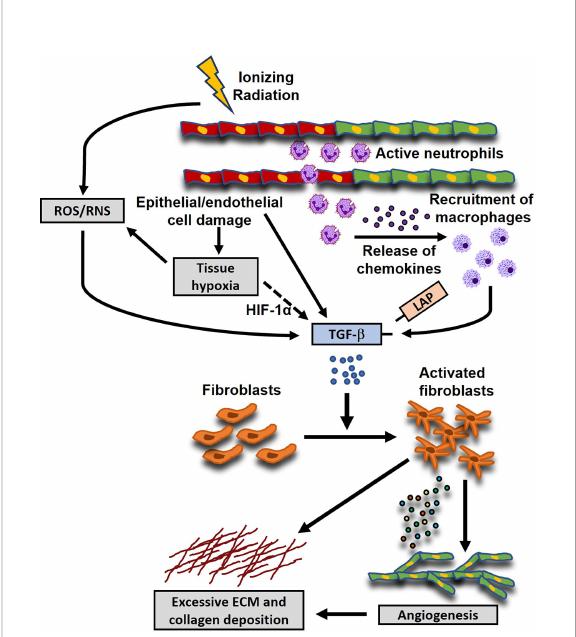
FIGURE 1 Proposed mechanisms of radiation-induced myocardial fi brosis (RIMF). Ionizing radiation damages epithelial and endothelial (shown here; red- and green-colored cells are damaged and healthy cells, respectively) cells which in turn induce a coordinated cellular response that also involves the secretion of pro- fi brotic cytokines, such as Transforming Growth Factor b (TGF- b ). Moreover, the damaged endothelial cells secrete in fl ammatory chemokines to recruit neutrophils and macrophages to the injured sites, which in turn release pro- fi brotic cytokines like Platelet-Derived Growth Factor (PDGF), basic Fibroblast Growth Factor (FGF), TGF- b , etc., leading to a chronic in fl ammatory environment. Additionally, radiation causes perturbations of the cellular homeostasis by the excessive production of reactive oxygen and nitrogen species (ROS and RNS), which can also lead to the activation of TGF- b through the dissociation of the Latency Associated Peptide (LAP) from the active mature form of TGF- b . Another potential mechanism is that the damaged vasculature and the uncontrolled tissue remodeling can initiate the TGF- b signaling pathway through the ROS/RNS imbalance or the up-regulation of the expression of Hypoxia-Inducible Factor 1 a (HIF-1 a ). The activated TGF- b signaling pathway leads to the differentiation and activation of the residual and migrated fi broblasts, characterized by the increased secretion of extracellular matrix (ECM) and collagen